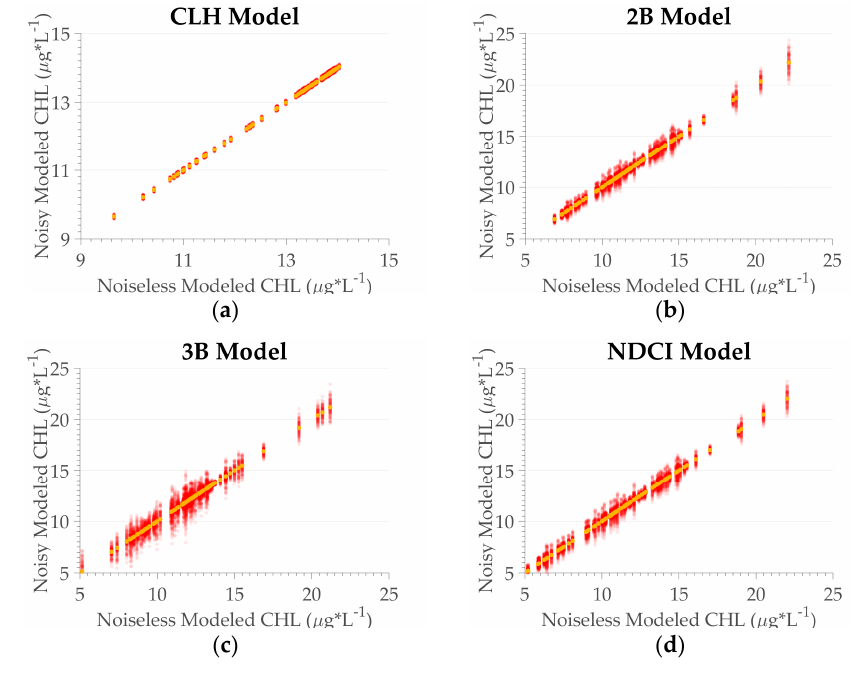
Figure 6. Algorithm performance for the chl-a concentration of the OLCI sensor. ( a ) CLH ; ( b ) 2B ; ( c ) 3B ; ( d ) NDCI . Circles in red represent the data with noise, circles in yellow the noiseless data. The transparency is based on the frequency distribution, in which opaque indicates a higher frequency, and transparent indicates a lower frequency.